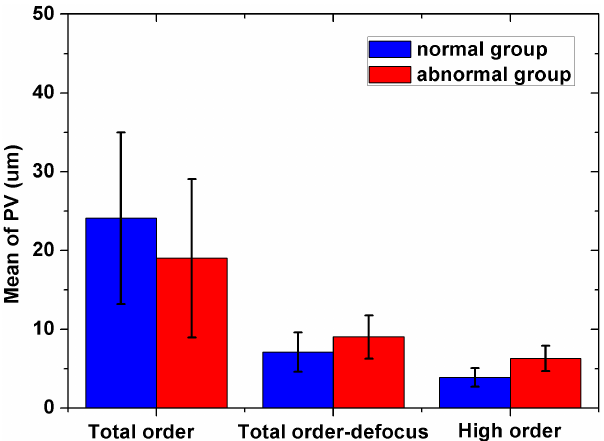
Fig. 3. PV values under three di®erent refraction in both normal and abnormal group. Mean values were shown by the symbols. The error bars in this ¯gure indicated (cid:1) standard deviations from the